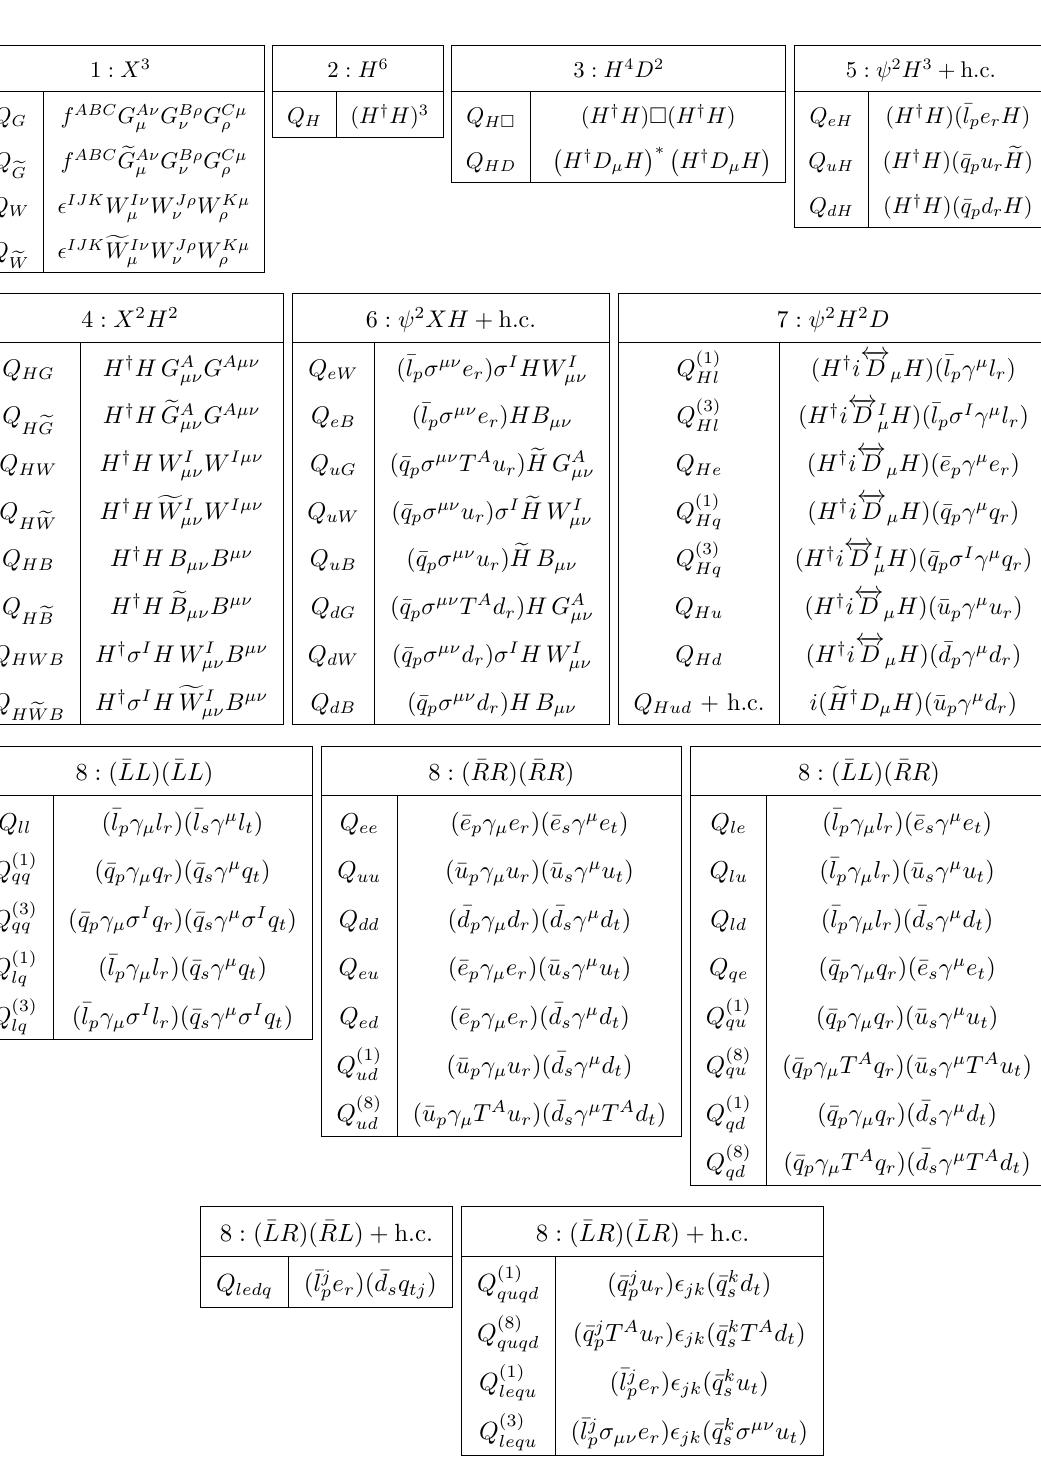
Table 3 . The 59 independent baryon number conserving dimension-6 operators built from Standard Model fields, in the notation of [59]. The subscripts p, r, s, t are flavor indices, and σ I are Pauli